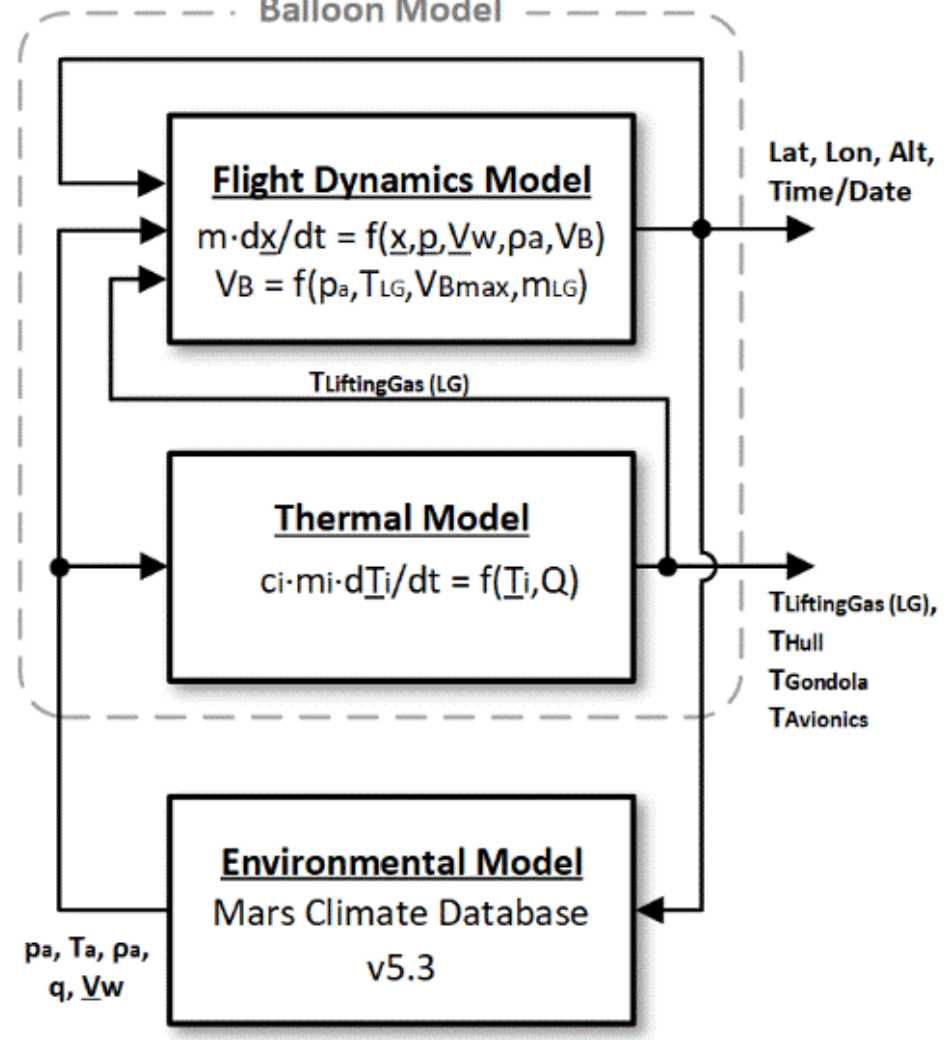
Figure 2. Simulator block diagram with principal model structure, governing equations and data interfaces. Depicted parameters are as follows: pressures p, temperatures T, densities ρ , solar and IR radiant fluxes q, masses m, energy capacities c, wind vector V w , balloon hull volume V B . Subscripts: ‘a’ atmosphere, ‘i’ thermal model node index.